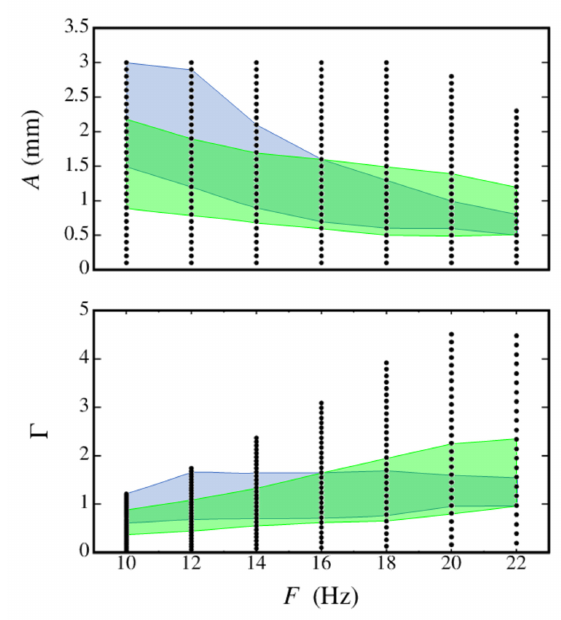
Figure 2. Amplitude ( top ) and dimensionless acceleration ( bottom ) of the forcing oscillations as functions of the exciting frequency. The regions where regular patterns are observed over the grid with small cells ( l = 2.5 cm; light blue areas) are compared with those where regular patterns are observed over the grid with larger cells ( l = 5 cm; green areas).